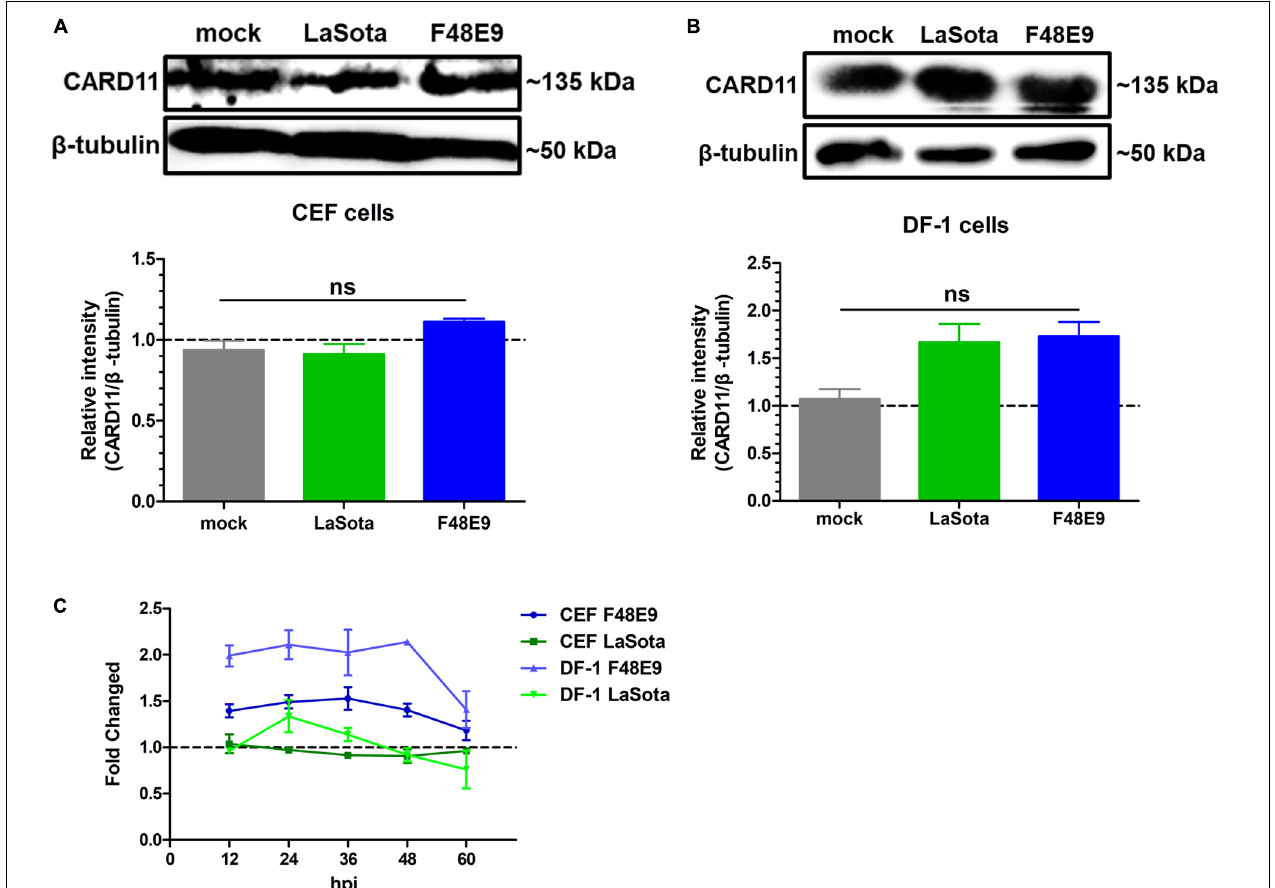
FIGURE 1 | CARD11 was not significantly upregulated by NDV infection in chicken fibroblasts. (A,B) CEFs (A) and DF-1 (B) cells seeded in 100-mm plates were infected with F48E9 (0.01 MOI) or LaSota (1 MOI), harvested at 36 hpi and detected using the IPE method. The expression levels of CARD11 relative to that of β -tubulin were analyzed by densitometry via ImageJ software. (C) The relative mRNA expression of CARD11 in viral-treated CEFs and DF-1 cells at different hpi was determined by qPCR normalized to the mRNA expression of 28S rRNA. All representative data from three independent experiments (mean ± SD) were analyzed with a two-tailed Student’s t -test. ns, not